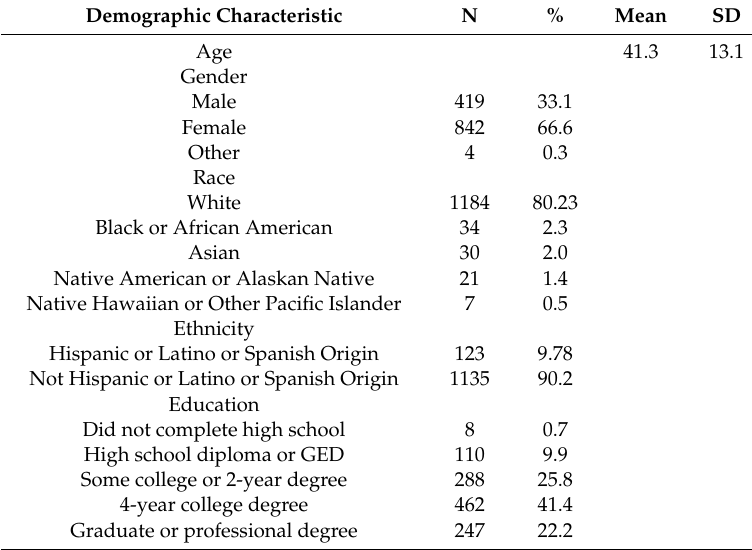
Table 1. Demographic characteristics of study